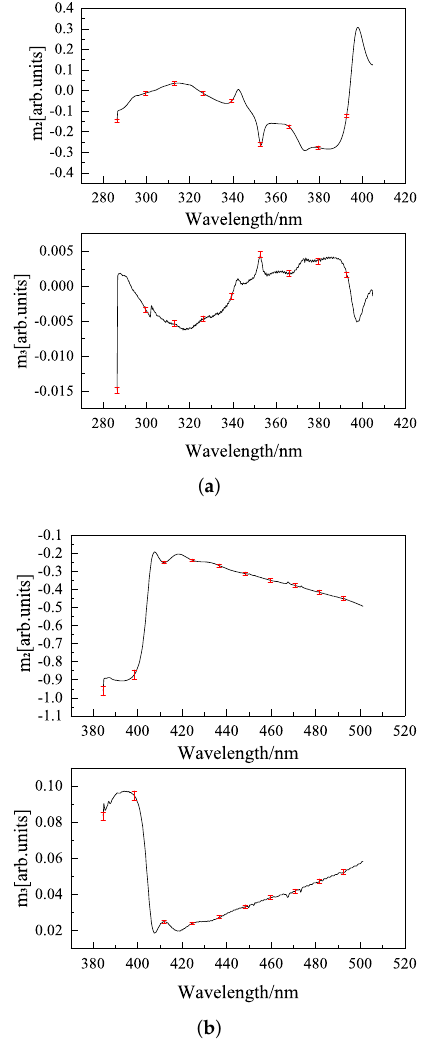
Figure 9. ( a ) Polarization responses m 2 and m 3 of channel 1 of the UV Hyperspectral Detector; ( b ) Polarization responses m 2 and m 3 of channel 2 of the UV Hyperspectral